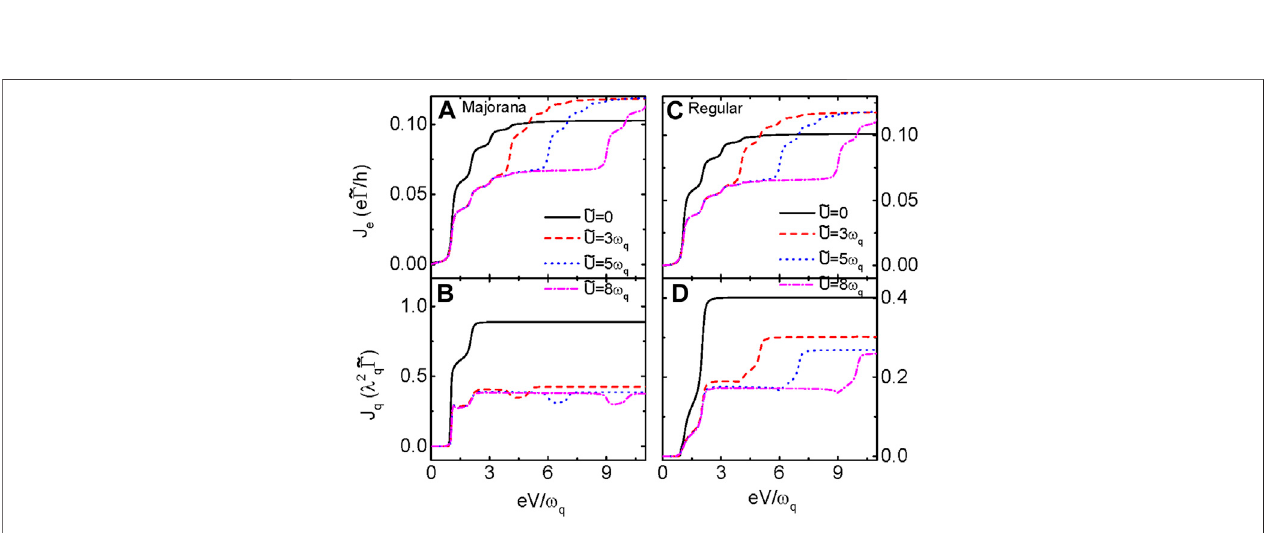
FIGURE 3 | (A) and (B) are individually for J e and J q in QD coupled to MBSs, and (C) and (D) are J e and J q in QD connected to regular fermions, respectively. The Coulomb interaction is chosen at different values with fi xed λ